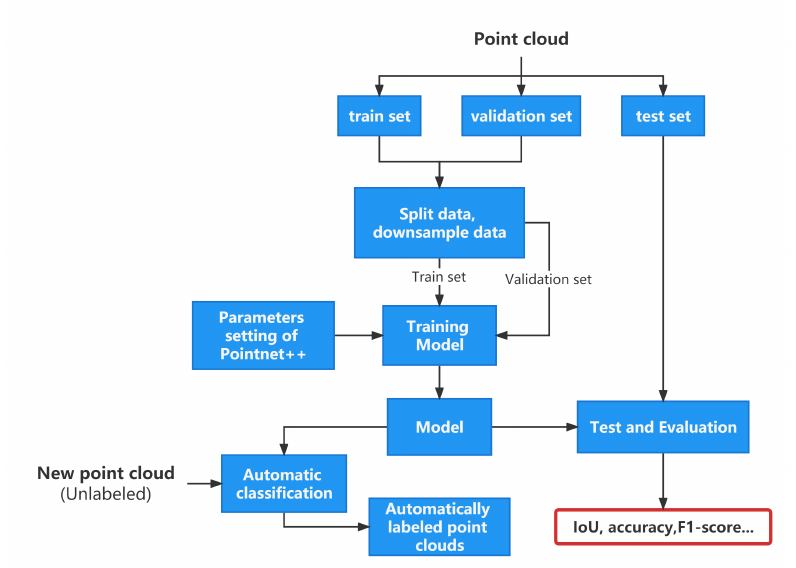
Figure 3. Principle of PointNet++ for large-scale TLS point clouds.